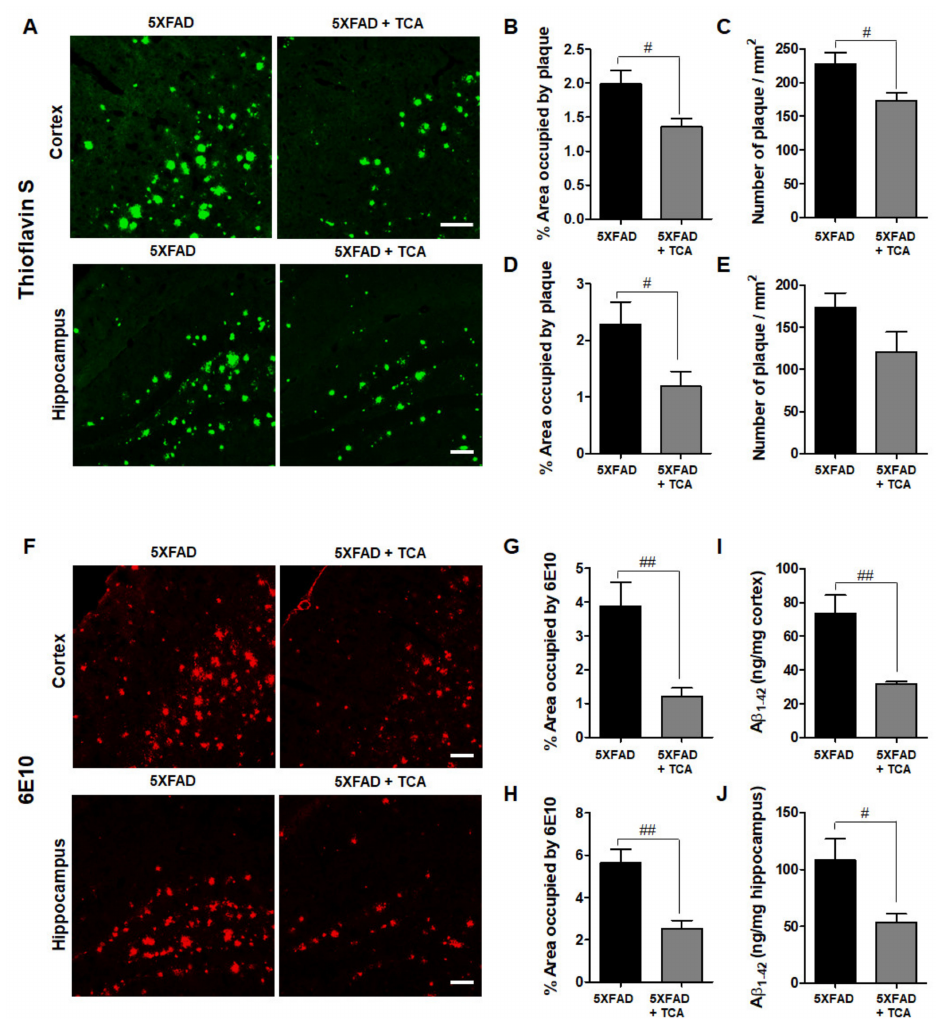
Figure 3. TCA reduces amyloid- β (A β ) deposition in the brains of 5XFAD mice. ( A ) Representative images of thioflavin S staining. We used mice as follows: vehicle-treated 5XFAD mice ( n = 6), TCA- treated 5XFAD mice ( n = 5). Scale bar: 100 µ m. ( B , D ) Areas occupied by A β plaques in the cortex ( B